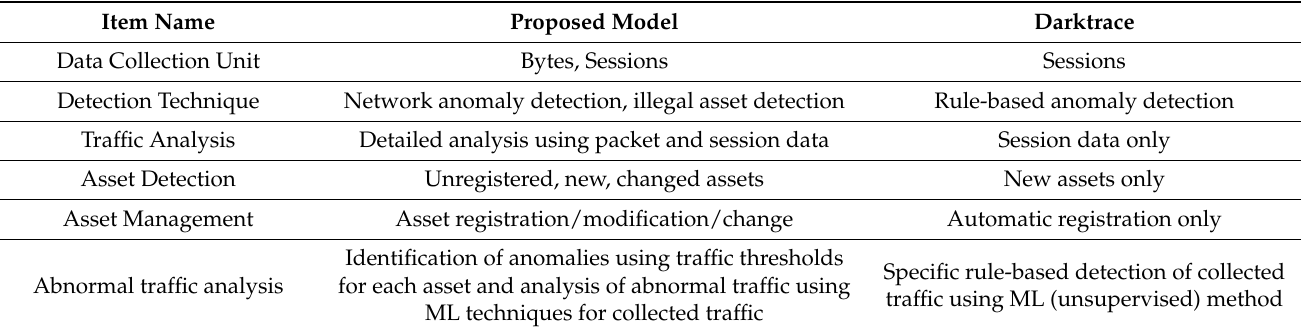
Table 4. Detection model comparison.